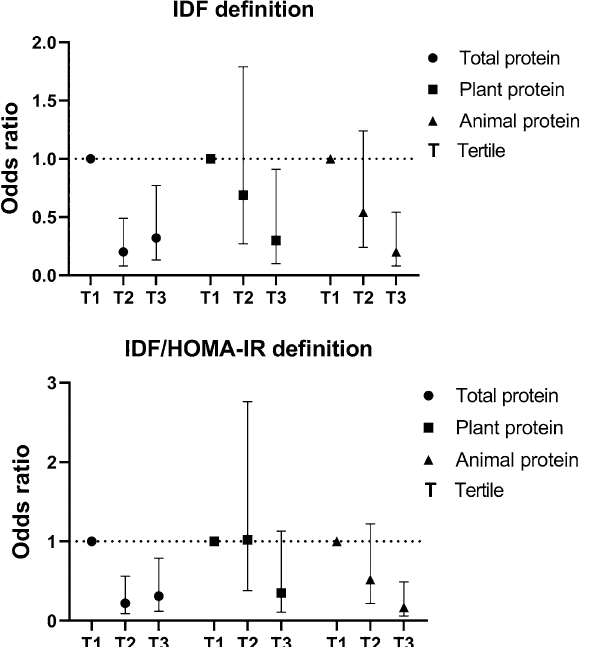
Figure 2. Multivariable-adjusted odds ratio and 95% CIs for MUO across tertiles of dietary total, plant, and animal protein intake. The estimates were adjusted for age, gender, energy intake, physical activity levels, socioeconomic status, total dietary fat intake, plant protein (for animal protein), animal protein (for plant protein) and BMI.